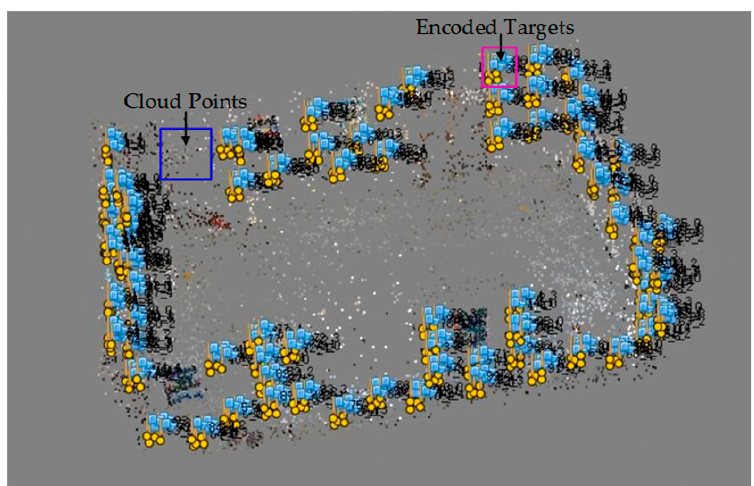
Figure 7. Point cloud 3D display of color encoded targets and feature points.